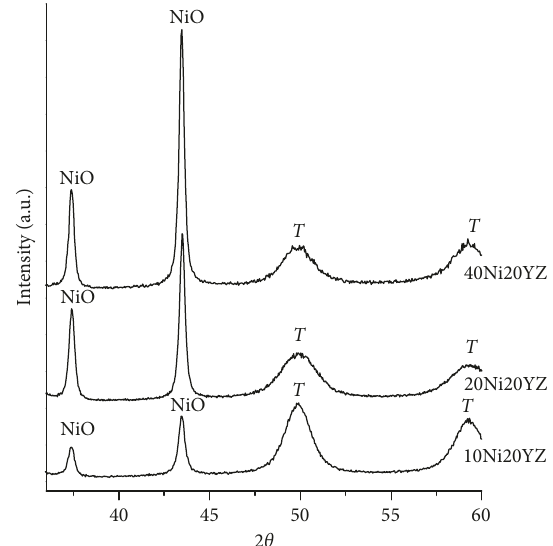
Figure 1: In situ XRD patterns of catalysts at room temperature (in the 2 θ � 35–60 ° range, speed 2 ° min − 1 using Cu K α radiation ( λ � 1.5406 ˚A), the diffraction patterns were identified by com- parison with the database of the International Centre for Dif- fraction Data—JCPDS).